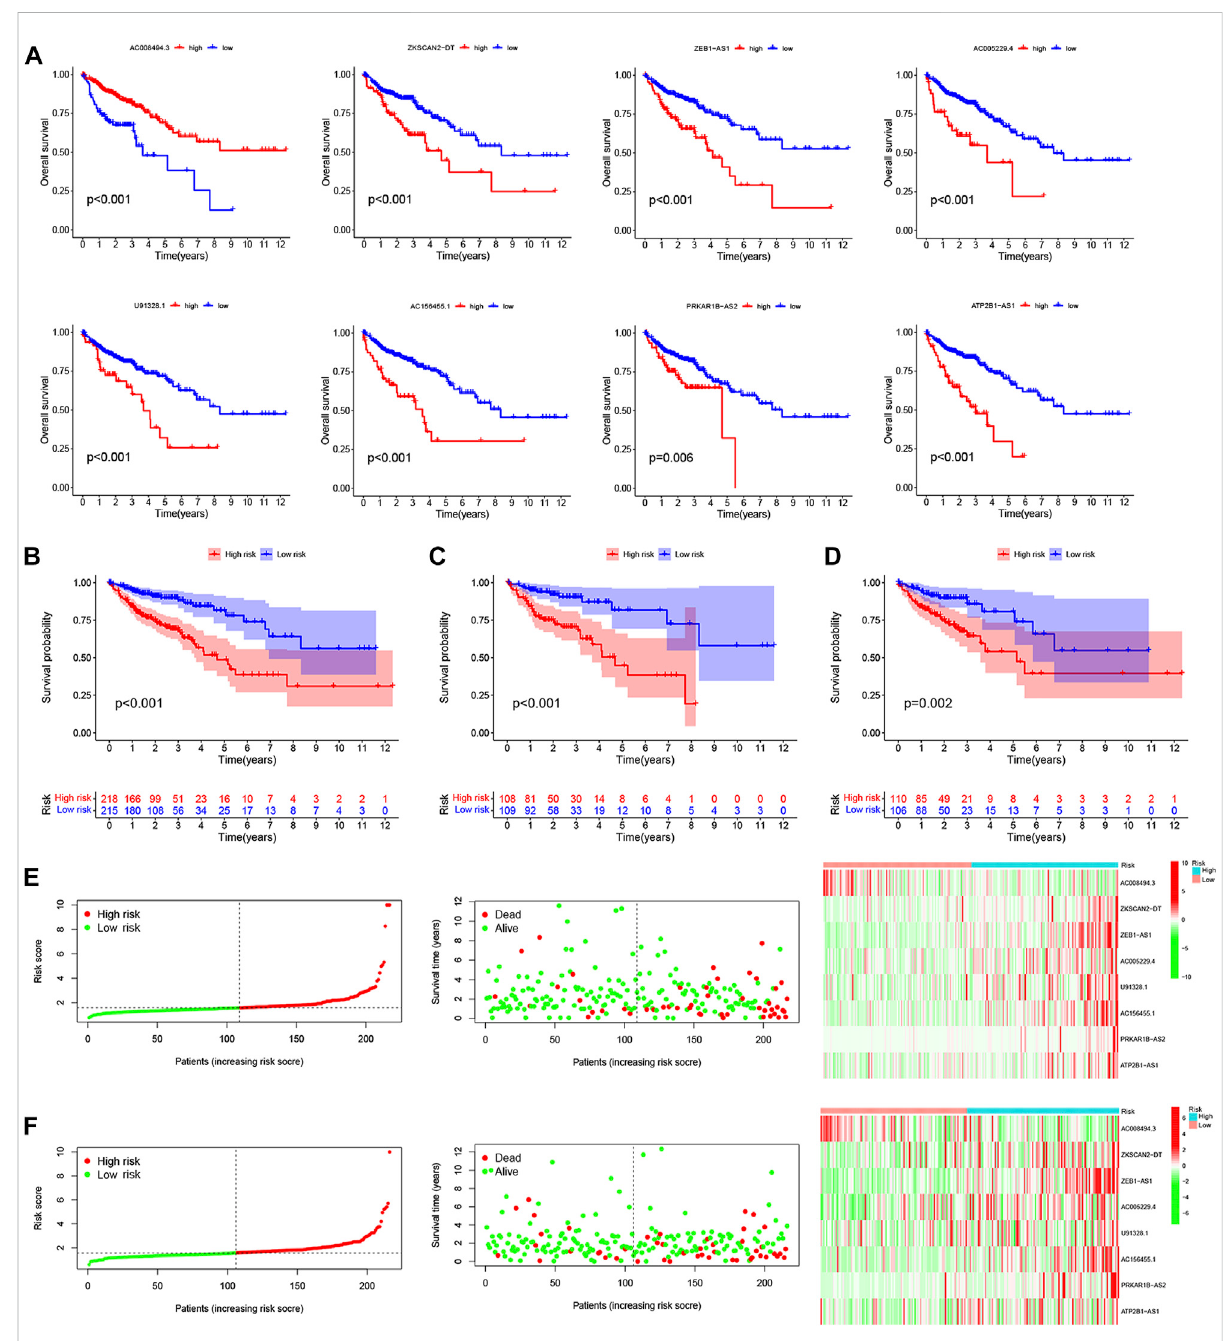
FIGURE 5 Construction and validation of a risk model based on the 8 m6A-related lncRNA signatures. The OS curve of 8 m6A-related lncRNA signatures for the low- and high-expression groups with the cut-off value 0.599 from TCGA cohorts (A) . Kaplan-Meier survival curves of the OS for patients in thecompletedataset (B) ,trainingdataset (C) ,andtestingdataset (D) betweenthehigh-andlow-riskgroup.Thedistributionoftheriskscore,survival time and survival status, and the heatmap of the 8 m6A-related lncRNA signatures in the training dataset (E) , testing dataset (F) between the high- and low-risk